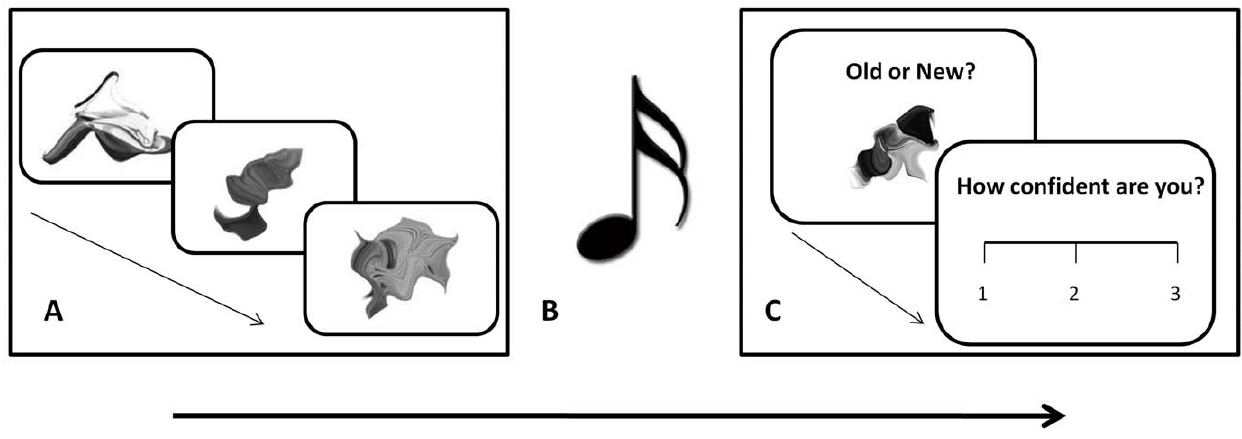
Figure 1. Experimental timeline. Four blocks of the experiment were conducted, each consisting of 3 phases. (A) Study phase; 20 abstract shapes were viewed for 5 seconds each. (B) Music exposure phase; music appropriate to the mood/arousal condition was played for 5 minutes. (C) Test phase; 20 old and 20 new shapes were presented. An old/new judgement was made, followed by confidence rating.